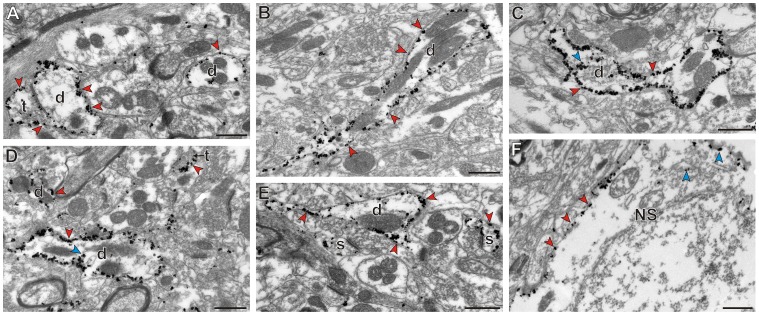
Channelrhodopsins are expressed almost exclusively at the neuronal plasma membrane.A-F: Examples of immunogold staining (indicating ChR2 expression) in the putamen. Arrowheads point at plasma membrane-bound (red arrows) or intracellular (blue arrows) gold particles. Abbreviations: d, dendrite; s, spine; t, terminal; NS, Neuronal soma. Scale bars: 0.5 µm (applies to all panels).